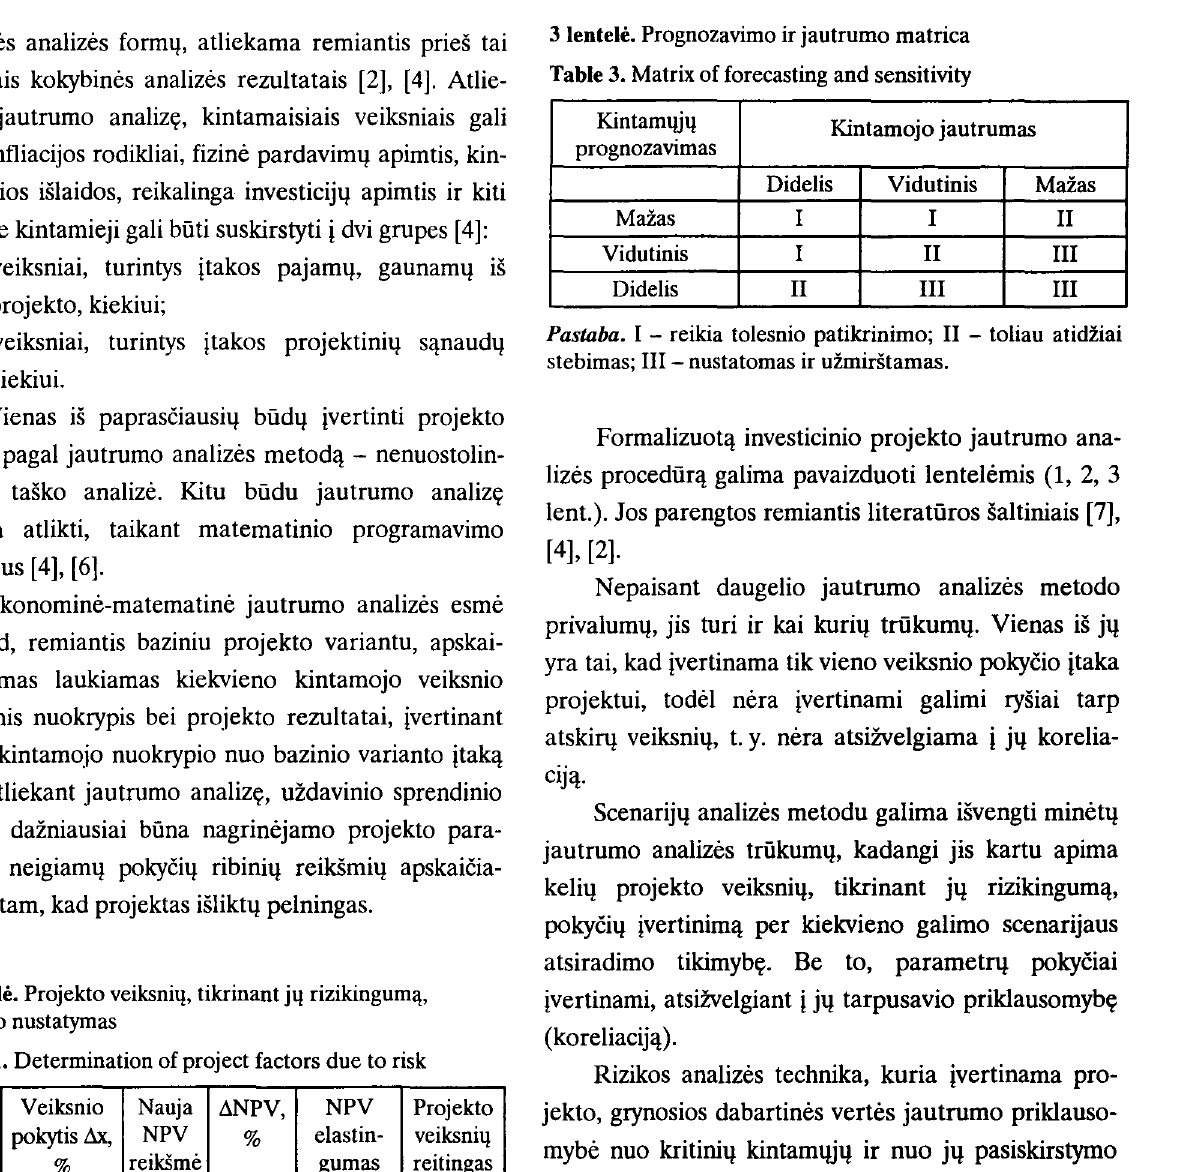
Table 1. Determination of project factors due to risk Kinta· Veiksnio Nauja llliPV, NPV Projekto mas is pokytis~. NPV % elastin- veiksniq reikSme gum as reitingas (llliPV I ~)